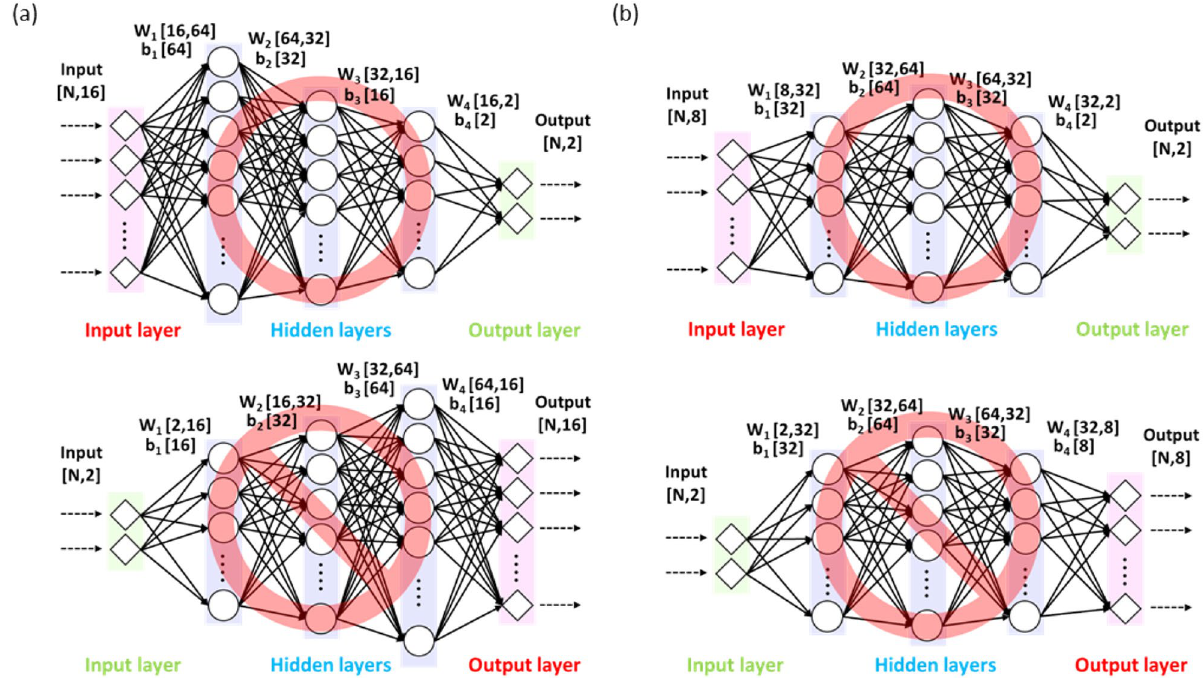
Figure 3. ( a ) The DNN architecture selected for 16 input features, and ( b ) for 8 input features, (top) along with inverse architectures that could never succeed